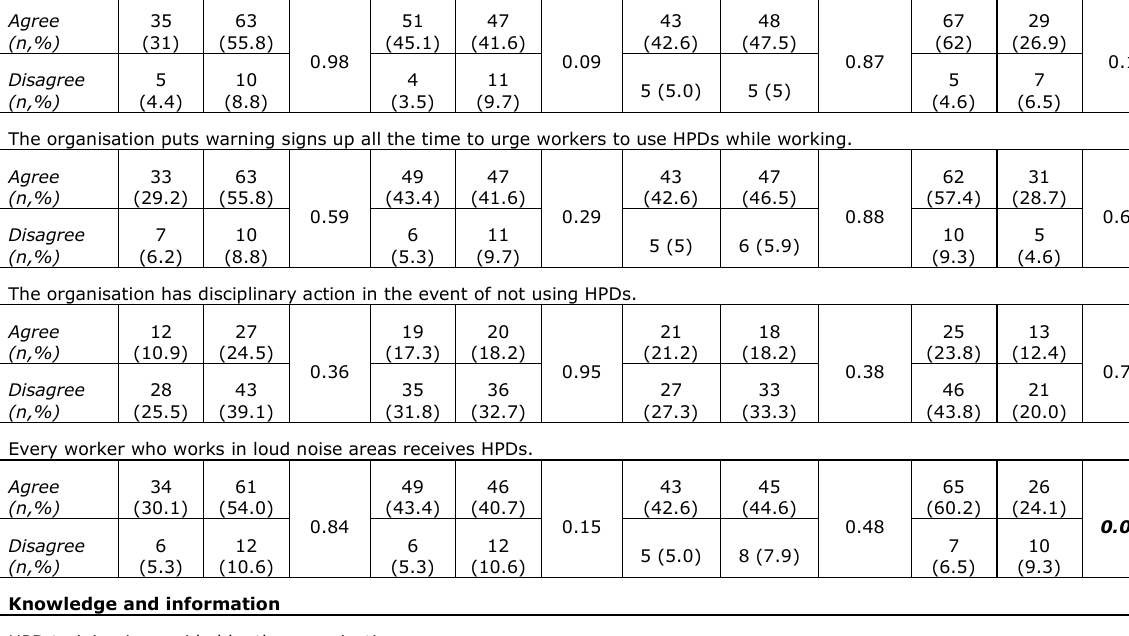
Table 3. Association between organisational rules, knowledge and information variables and perception of wearing HPDs Duration of exposure Duration working for the to noise Age (Years) company (Years) (Hours) Variables p- p- ≤35 >35 ≤ 4 > 4 ≤ 10 >10 value value